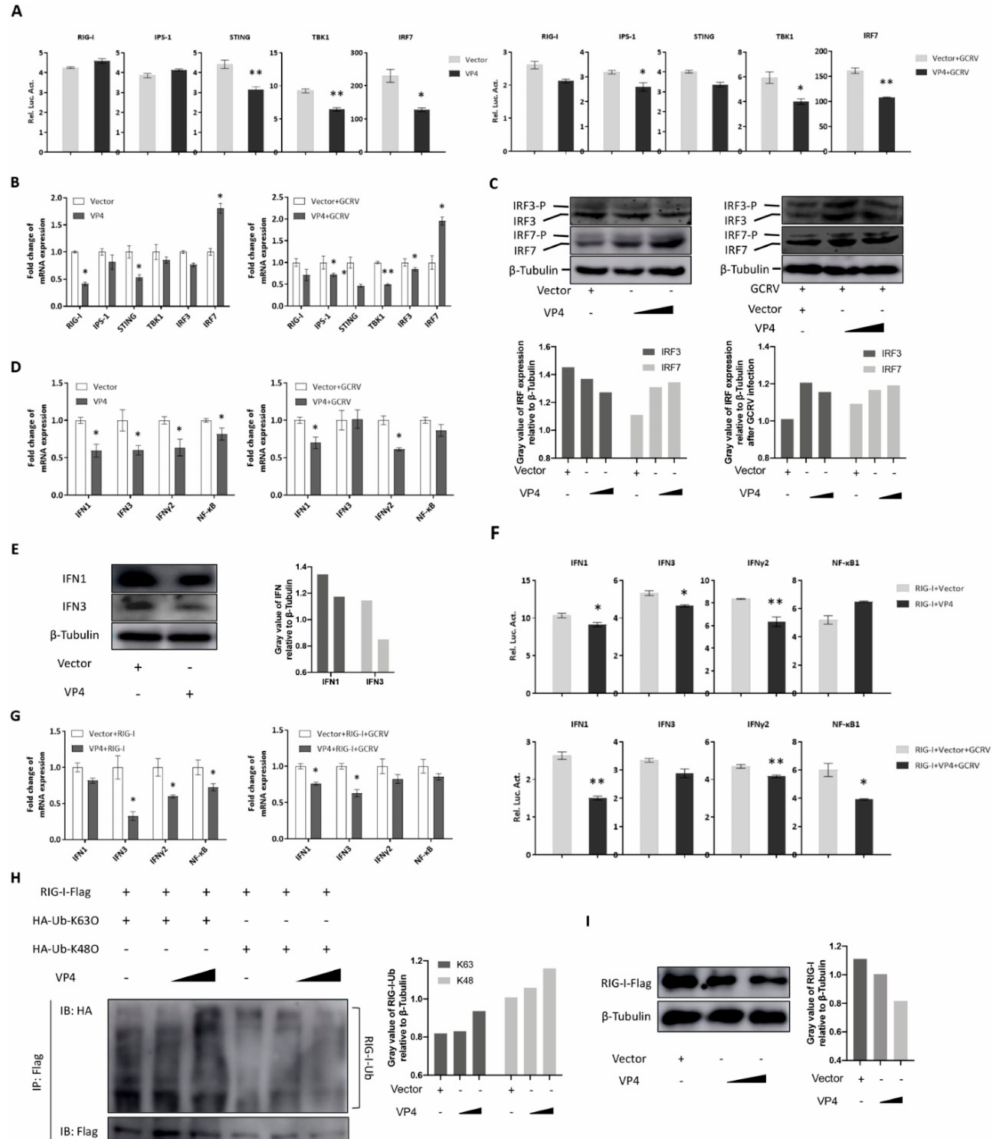
Figure 4. VP4 associated with RIG-I inhibits RLR triggered-IFN responses. ( A ) VP4 overexpression inhibitsRLRsignalingpathwaykeygenepromoteractivities. CIKcellsseededin24-wellplatesovernight were co-transfected with 380 ng of VP4 / empty vector, 380 ng of each target plasmid (pRIG-Ipro-Luc, pIPS-1pro-Luc, pSTINGpro-Luc, pTBK1pro-Luc and pIRF7pro-Luc) and 38 ng of pRL-TK. 24 h later, the cells were infected with GCRV or uninfected. The luciferase activities were examined at 24 h post-challenge. ( B ) VP4 overexpression decreases RLR related gene mRNA expressions in uninfected (left) or GCRV infected (right) CIK cells. CIK cells transiently transfected with VP4 / empty vector were seeded in 12-well plates. After 24 h, CIK cells were uninfected (left) or infected with GCRV (right). 24 h post-infection, total RNA was extracted and examined for RIG-I, IPS-1, STING, TBK1 and IRF7 mRNA expression. ( C ) VP4 reduces IRF3 but induces IRF7 protein expression and phosphorylation. CIK cells transiently transfected with VP4 / empty vector were seeded in 6-well plates. After 24 h, CIK cells were uninfected (left) or infected with GCRV (right). 24 h post-infection, cell lysate was used for WB analysis using IRF3 / IRF7 polyclonal antiserum. β -Tubulin was used to normalize the protein concentration. All the experiments were repeated independently at least three times. The histograms below the western blotting results exhibit the relative expression levels, which were quantified using ImageJ software. ( D ) VP4 overexpression decreases IFN1, IFN3, IFN γ 2 and NF- κ B1 mRNA